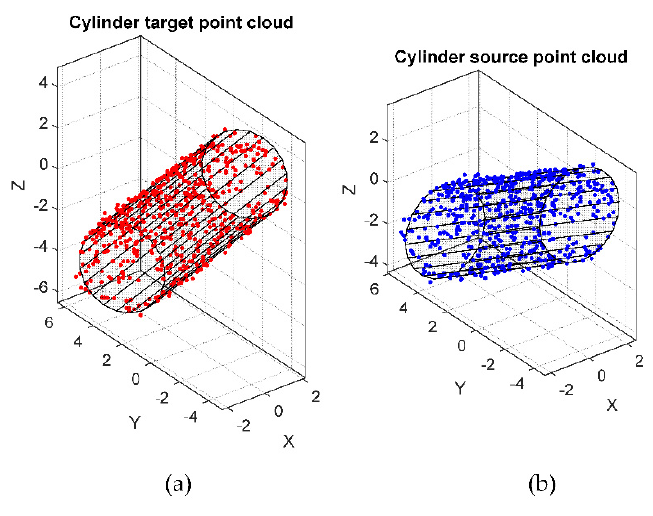
Figure 2. ( a ) The original shape (Target point-cloud) and ( b ) the 3-D transformation (Source point-cloud).